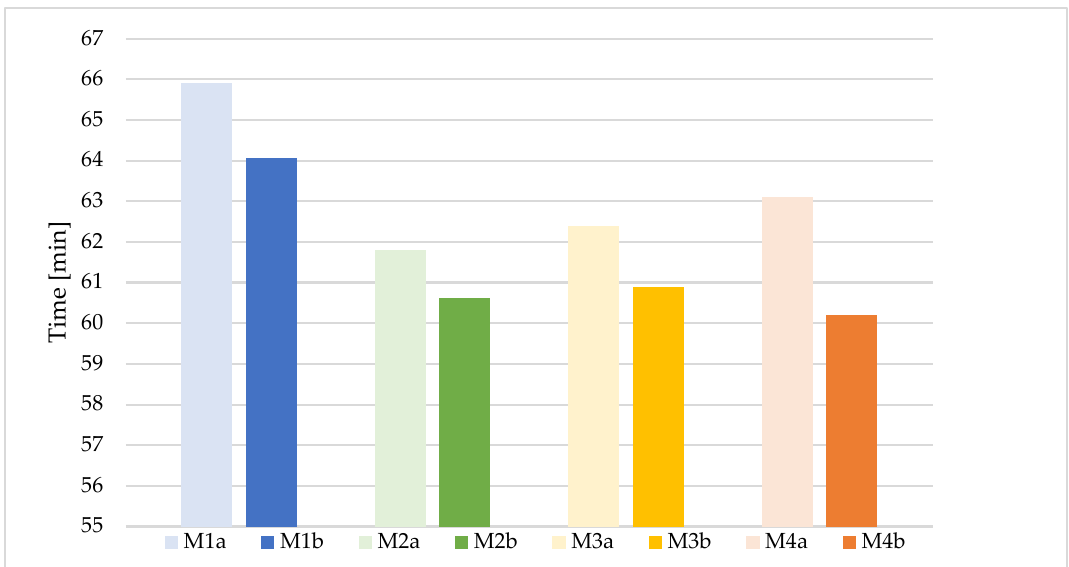
Figure 13. Preheating time, which represents the time required to heat up the PCM material from initial temperature to the start of the PCM material melting (57 °C) for all models and working fluid velocity magnitudes.